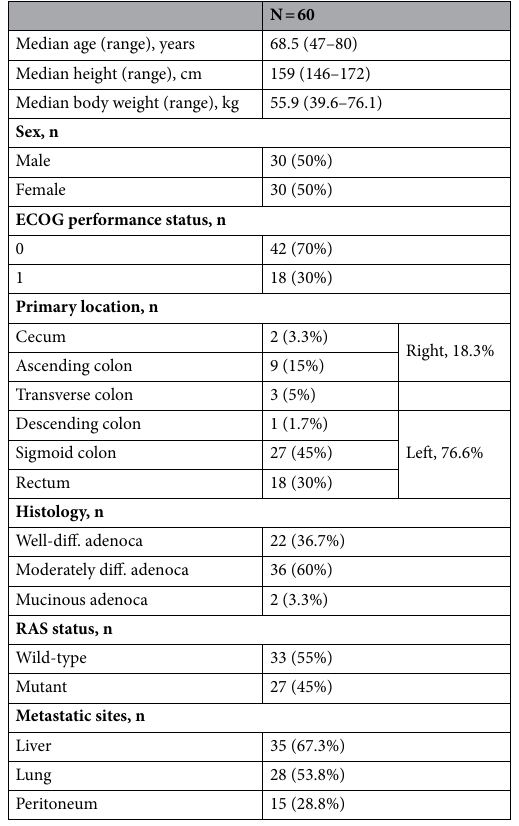
Table 1. Baseline characteristics. Ratio of right and left colon, excluding transverse colon was calculated for site of primary lesion. ECOG Eastern Cooperative Oncology Group, diff. differentiated; adenoca.,